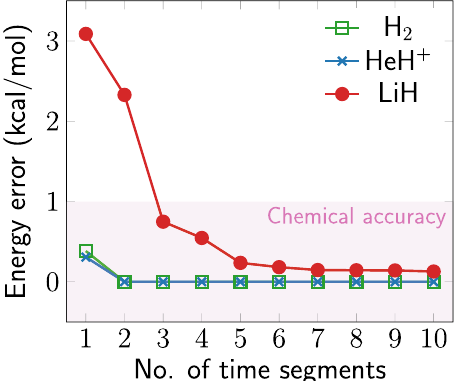
Fig. 8 Convergence of pulse parameterization. Energy difference of ctrl-VQE relative to FCI with increasing number of time-segments in the square pulse used.